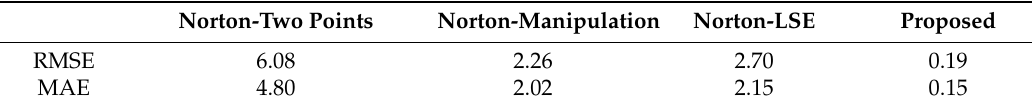
Table 3. Comparisons between the proposed method and Norton-based methods for 3rd harmonic current w.r.t. RMSE and MAE.